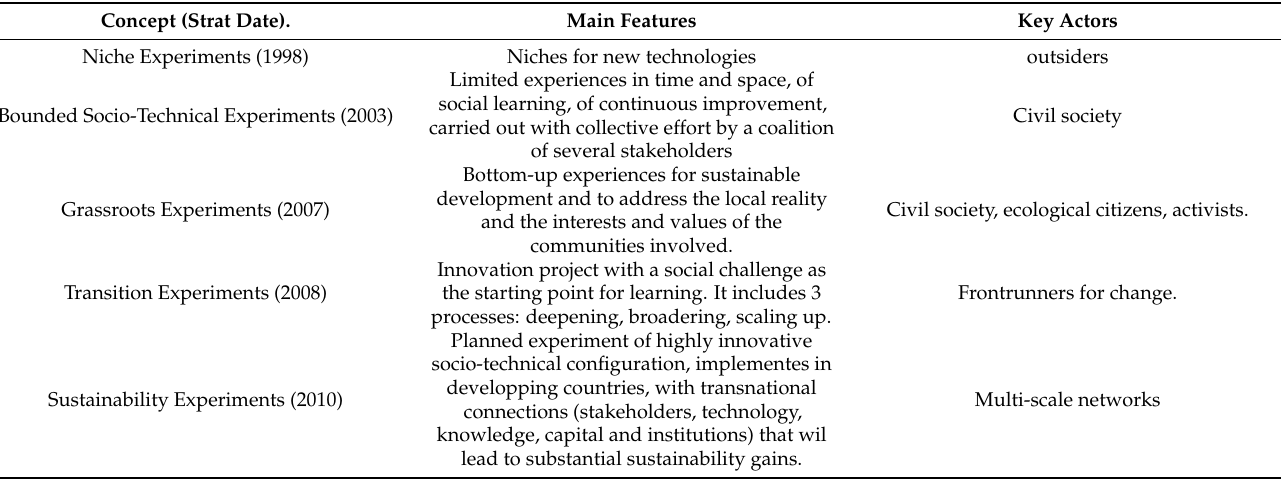
Table 2. Conceptual synthesis of urban experiences for sustainability transitions. Elaborated by the authors based on Sengers